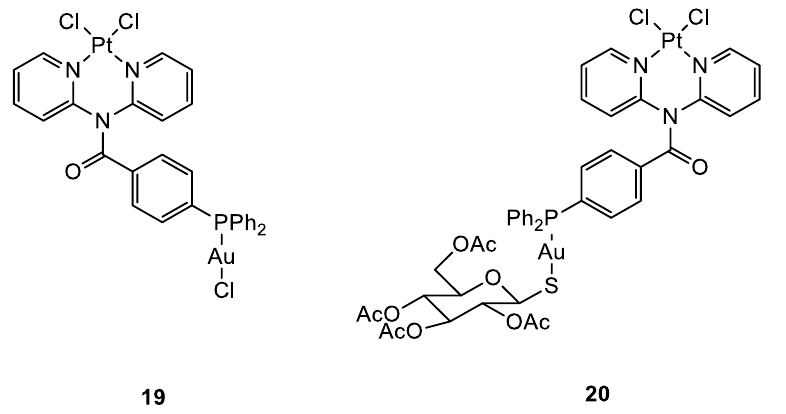
Figure 10. Molecular structure of compounds 19 and 20 .